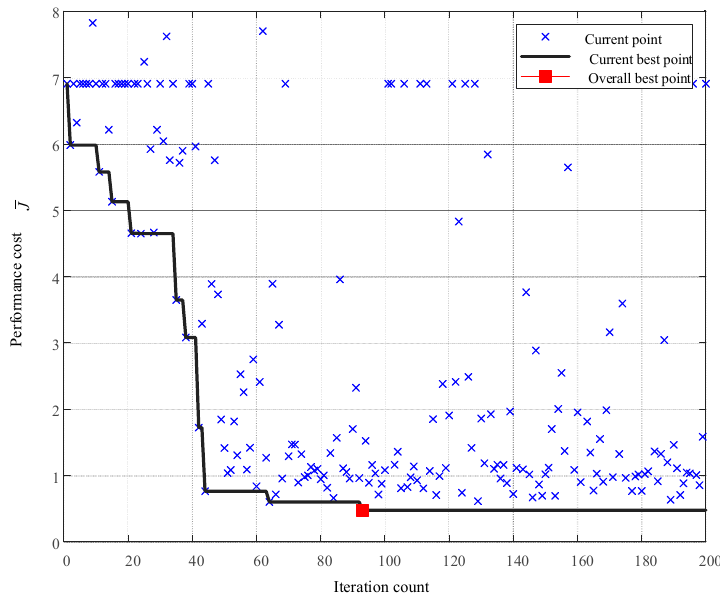
Figure 4. Performance-driven parameter tuning.